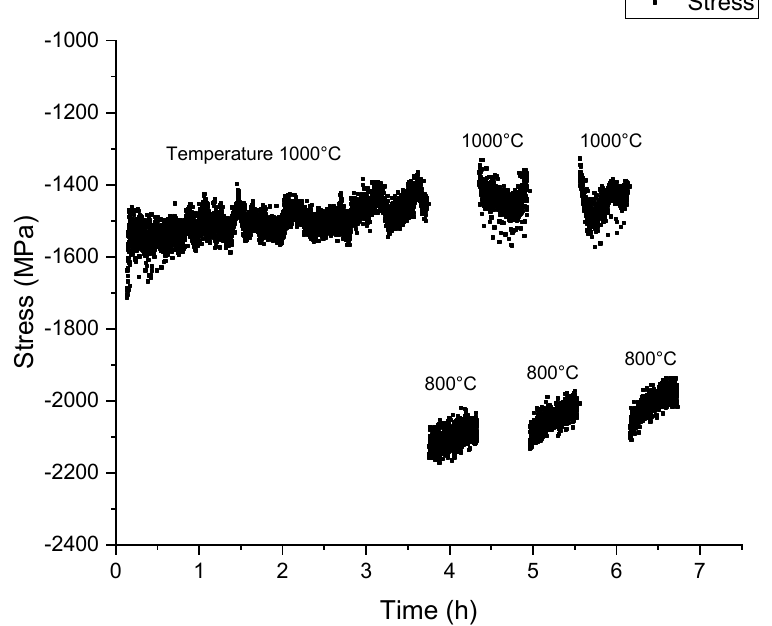
Figure 13. Stress evolution in the oxide versus time for R0.58. The uncertainty for each plateau is around 150 MPa, except for the first plateau for which uncertainty is around 200 MPa.